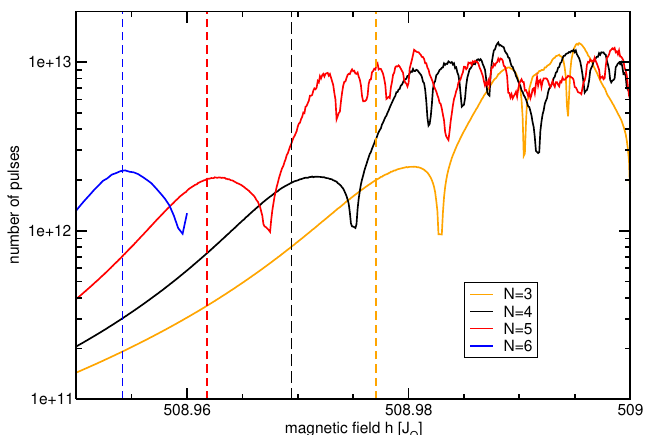
= 0.01) are plotted thresh